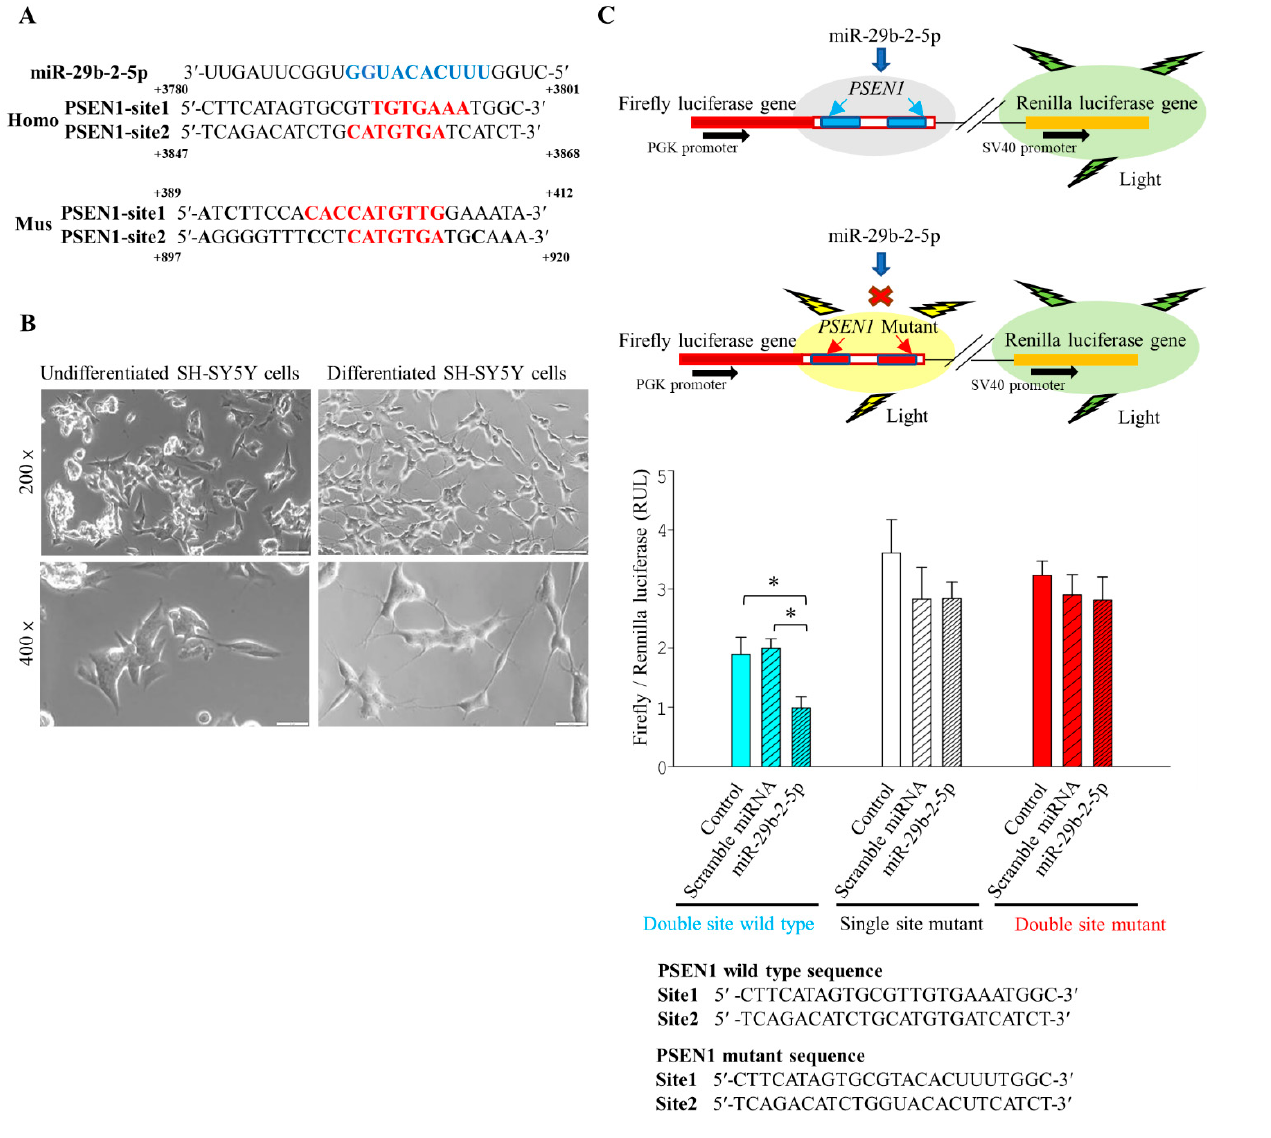
Figure 2. Luciferase assay indicated that miR-29b-2-5p targets 3 (cid:48) UTR of PSEN1 in SH-SY5Y cells. ( A ) Sequence and predicted base pairing of human miR-29b-2-5p with PSEN1 . Two predicted target sites in human PSEN1 3 (cid:48) UTR are located at 3791–3797 and 3856–3862 nucleotides from the start of PSEN1 3 (cid:48) UTR. Mouse PSEN1 3 (cid:48) UTR are located at 397–404 and 908–914 nucleotides from the start of PSEN1 3 (cid:48) UTR. ( B ) Differentiated neuronal SH-SY5Y cells ( left ) are morphologically distinct from undifferentiated SH-SY5Y cells ( right ). Scale bars represent 100 µ m ( up ) and 50 µ m ( down ) ( C ). The pmirGLO vector is designed to quantitatively evaluate PSEN1 activity by inserting PSEN1 3 (cid:48) UTR target sites downstream of the firefly luciferase gene, and the Renilla luciferase gene provides the necessary information normalization. The target sites of wild-type and mutant reporter constructs were transfected into neuronal SH-SY5Y cells alone or with 50 nM miR-29b-2-5p. The relative ratios of Renilla and firefly luciferase activity were measured. The expression of wild-type PSEN1 decreased the expression of the reporter (blue bar). PSEN1 single-site-2 mutation (white bar) or PSEN1 double mutation (red bar) of miR-29b-2-5p abolished the inhibitory effect of miR-29b-2-5p on reporter expression The miR-29b-2-5p mimic significantly reduced the luciferase expression of the wild-type reporter (52.05%). This decrease in luciferase expression was diminished by mutation at one site in the reporter (74.31%) and abolished by two mutations in the reporter (86.97%). Blue bar: Control